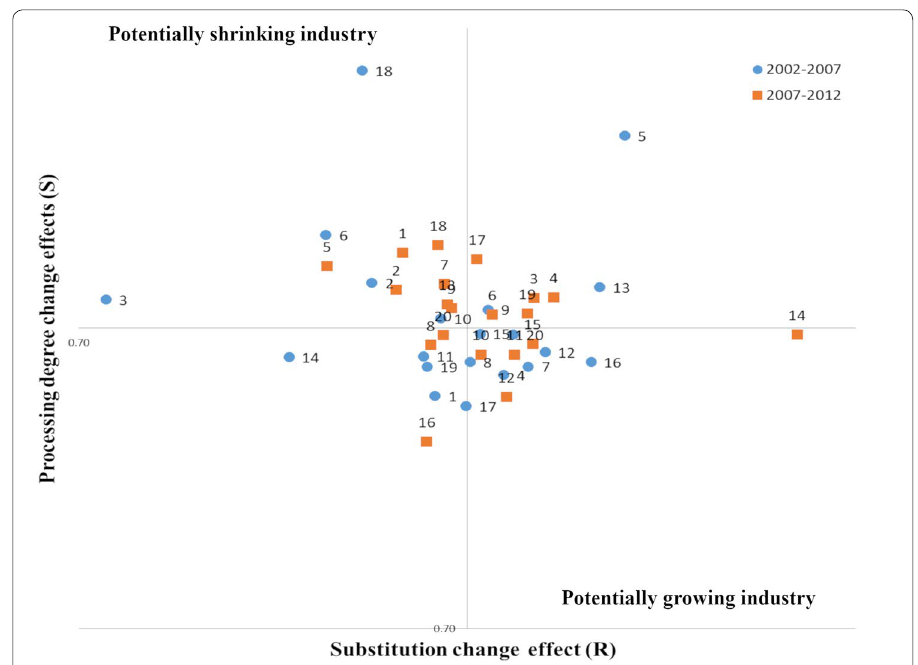
Fig. 1 Indices of substitution and processing